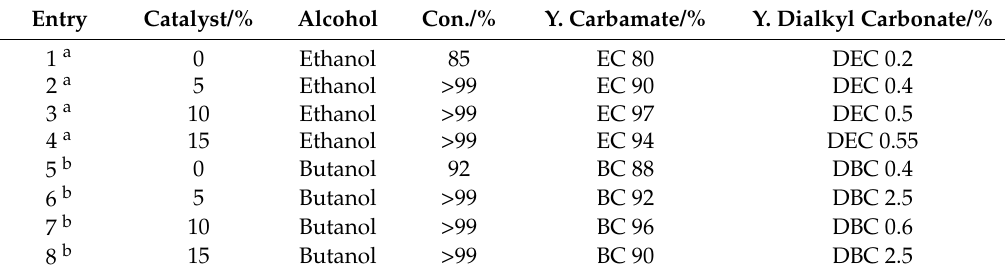
Table 5. Effect of catalyst amount on synthesis of EC and BC * .